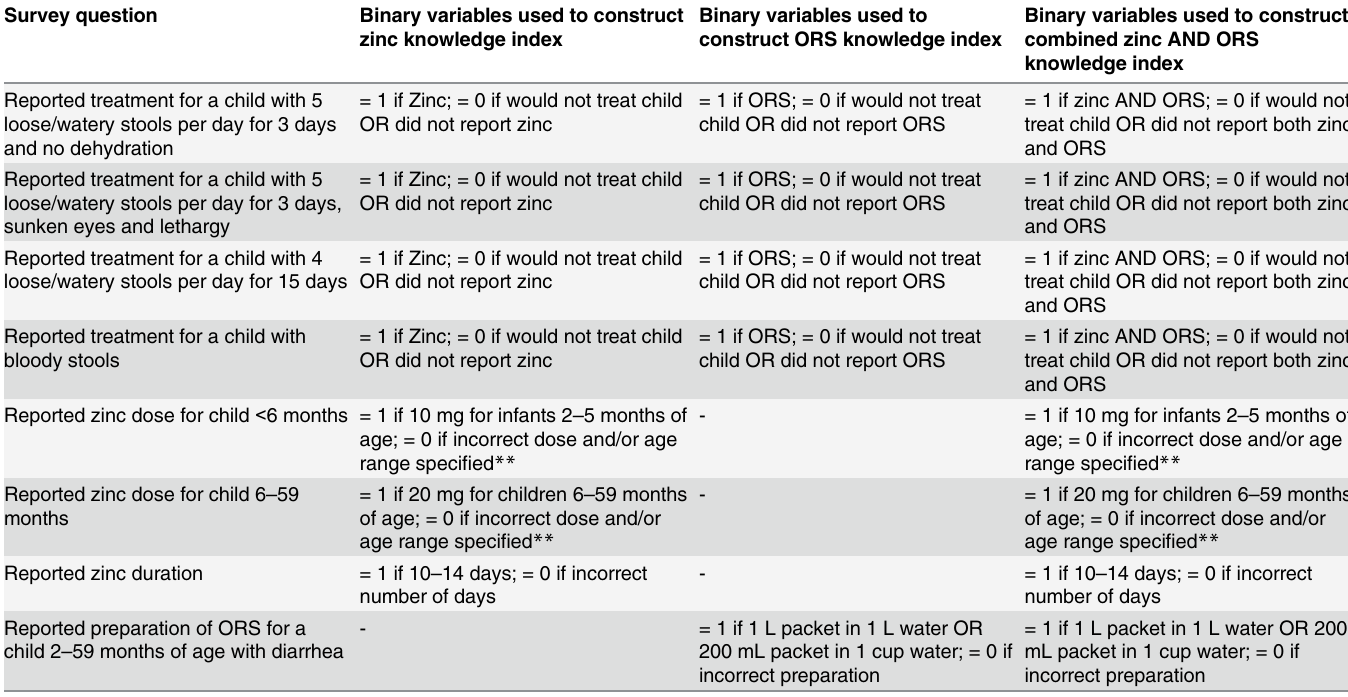
Table 1. Binary variables of zinc and ORS knowledge.